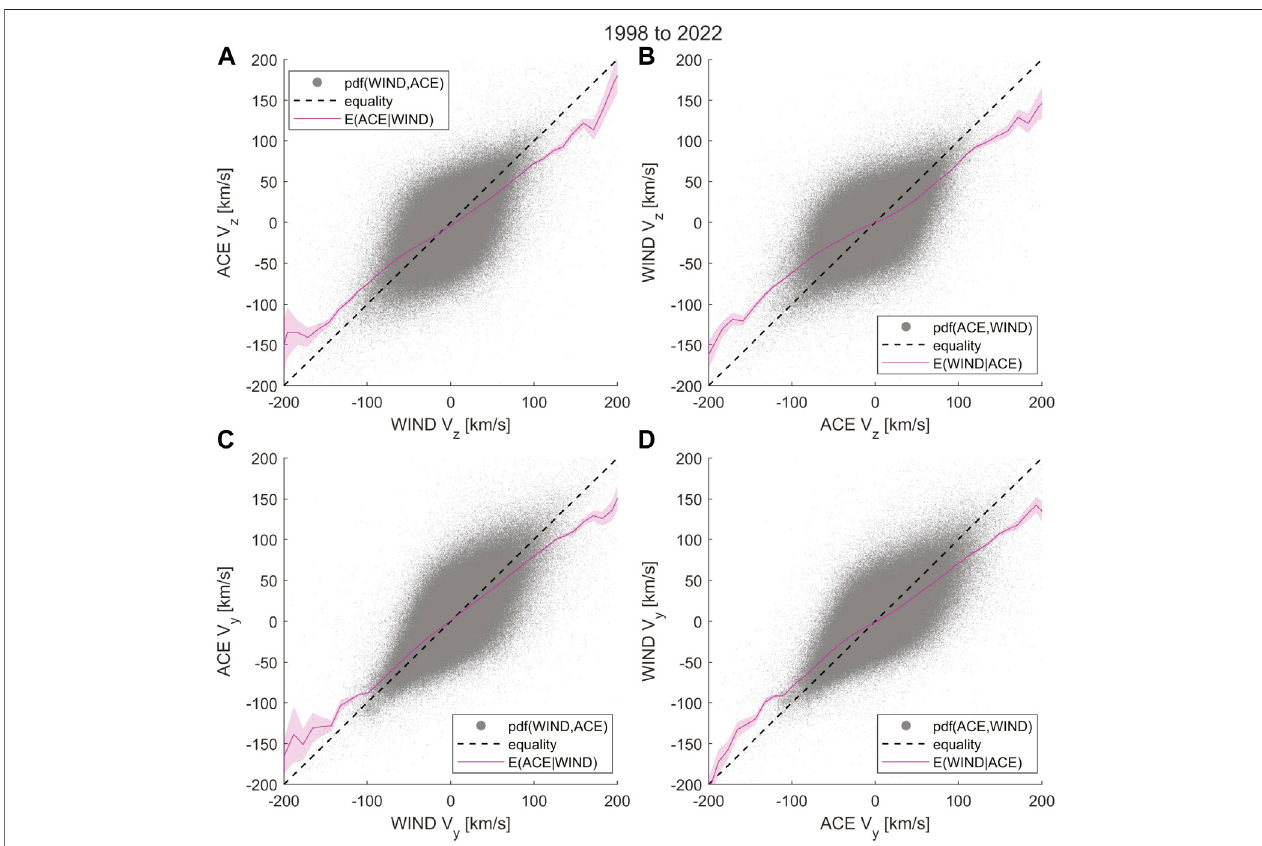
FIGURE 7 | Regression bias in solar wind velocity V z and V y in GSE coordinates. (A) Shows a scatter plot of 1-min resolution propagation delay-corrected ACE Vz vs. WIND V z . The dashed black line is the line of equality, and the magenta line is the conditional expectation E ( V ACE z | V WIND z ) or the regression function. (B) Shows the same but reverse. The scatter plot is of WIND V z vs. ACE V z . However, the magenta line is the reverse regression function E ( V WIND z | V ACE z ) . (C) Is the same as (A) but for the y-component of the solar wind velocity. (D) Is the same as (B) but for the y-component of velocity as